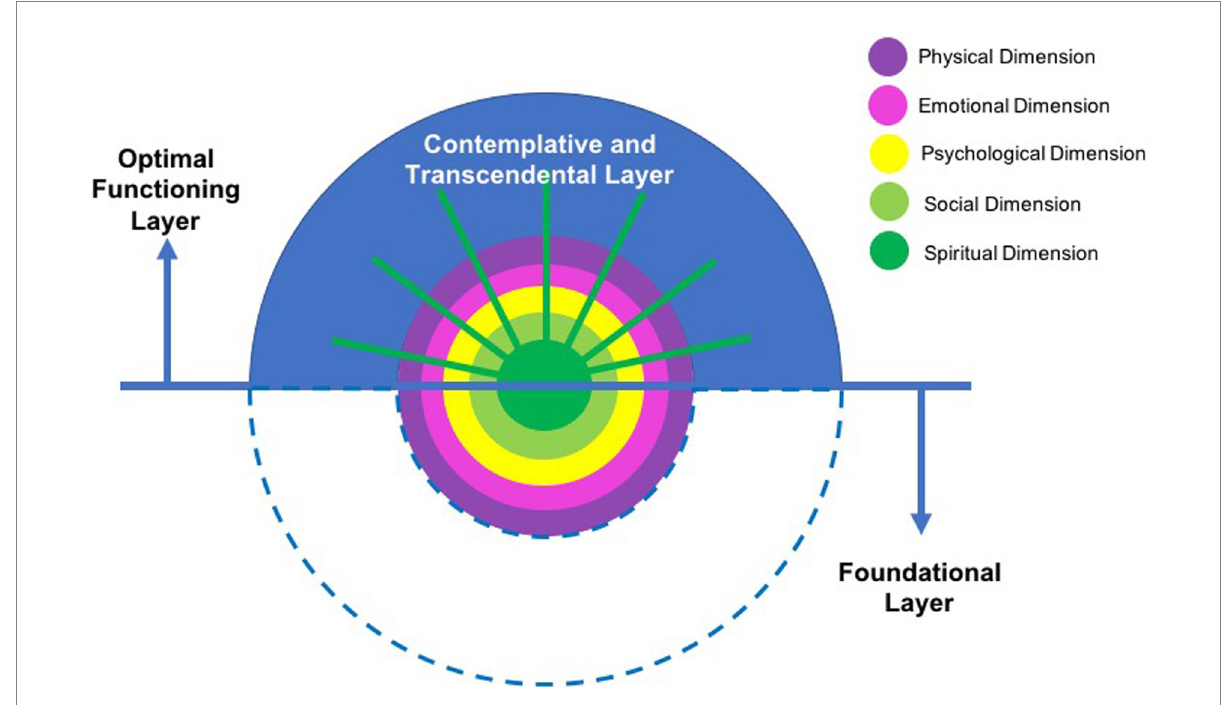
FIGURE 7 Levels of functioning in relation to dimensions of